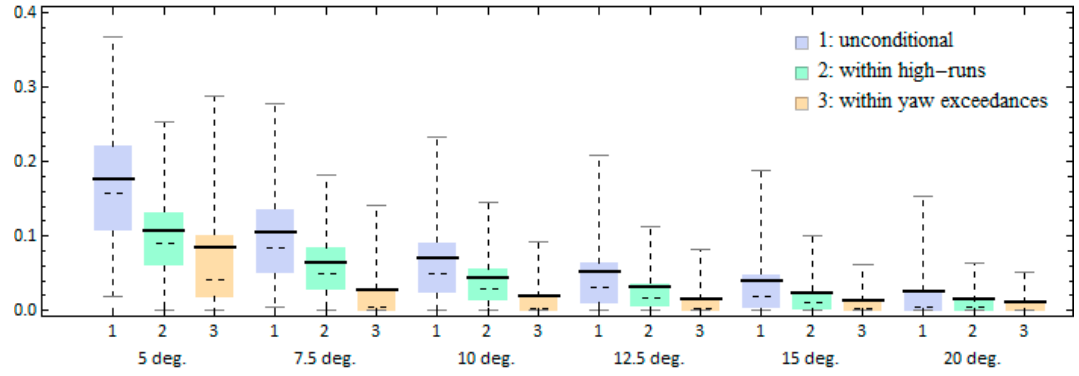
Figure 14. Effect of roll angle threshold limit on the time-ratio of roll exceedance (KG = 7.25 m).